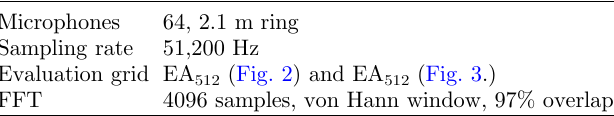
Table 5. Important parameters for the directed sample